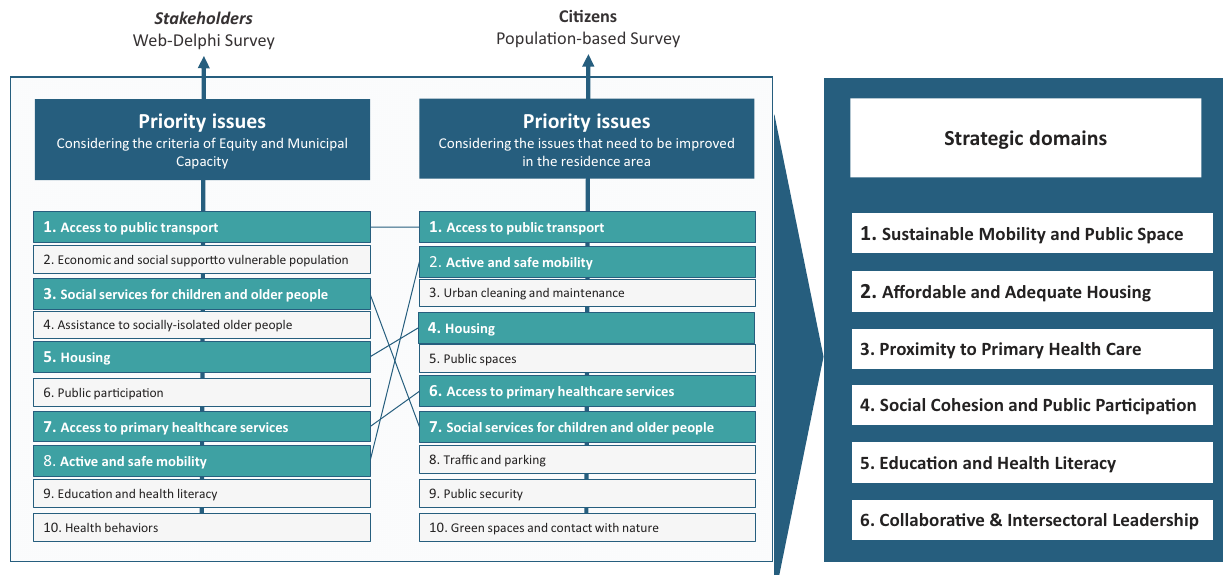
Figure 7. Comparison between priorities identified by local stakeholders and by citizens and their alignment with the strate‐ gic domains. Source: Câmara Municipal de Coimbra and University of Coimbra